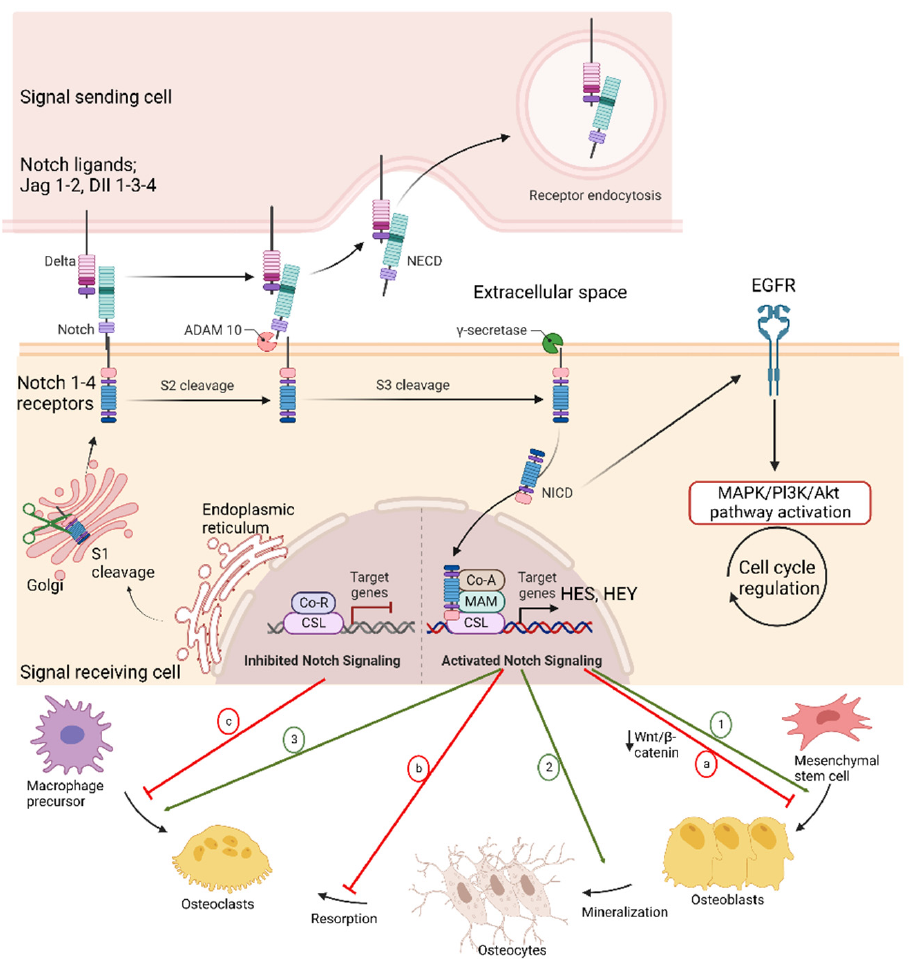
Figure 2. Regulation of Notch signaling. Notch inactive signal peptide precursor is synthesized in endoplasmic reticulum and moves to Golgi. After S1 cleavage process by furin-like convertases, it is translocated into the cell membrane. Following signal transduction from adjacent cell, S2 cleavage occurs via the disintegrins and metalloproteinases (ADAM). Truncated notch fragment is further processed by S3 and S4 cleavage, and thus, Notch intracellular domain (NICD) forms. NICD is the active form of the Notch receptor, which can direct transcriptional activity by entering the nucleus [53]. Notch signaling activation stimulates osteogenic differentiation and bone mineralization while inhibiting osteogenesis by suppressing Wnt/ β -catenin signaling. Notch inhibition by a signaling inhibitor can enhance osteogenesis (1, 2 and a). Activated Notch signaling in osteocytes can suppress bone resorption and increase bone density by reducing sclerostin and dickkopf Wnt signaling pathway inhibitor 1 while upregulating Wnt signaling (b). Notch 1-3 deficiency directly promotes osteoclastic differentiation, and Notch1 deficiency can promote this process indirectly by decreasing OPG and RANKL ratio. The Notch1/Jagged1 suppresses osteoclastogenesis, whereas the Notch2/Delta-like (DLL) 1 activates. Notch activation affects osteoclast formation since it strongly inhibits M-CSF (3 and c) [54]. Adapted from “Notch Signaling Pathway”, by BioRender.com (2022). Retrieved from https://app.biorender.com/biorender ‐ templates.